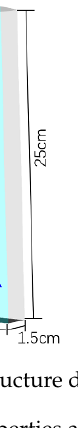
Table 3. Properties and settings used in the simulation.